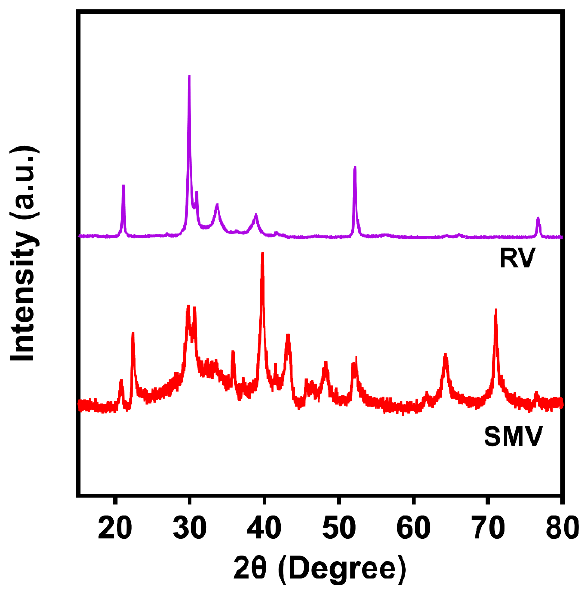
Figure 3. WA-XRD patterns of RV and